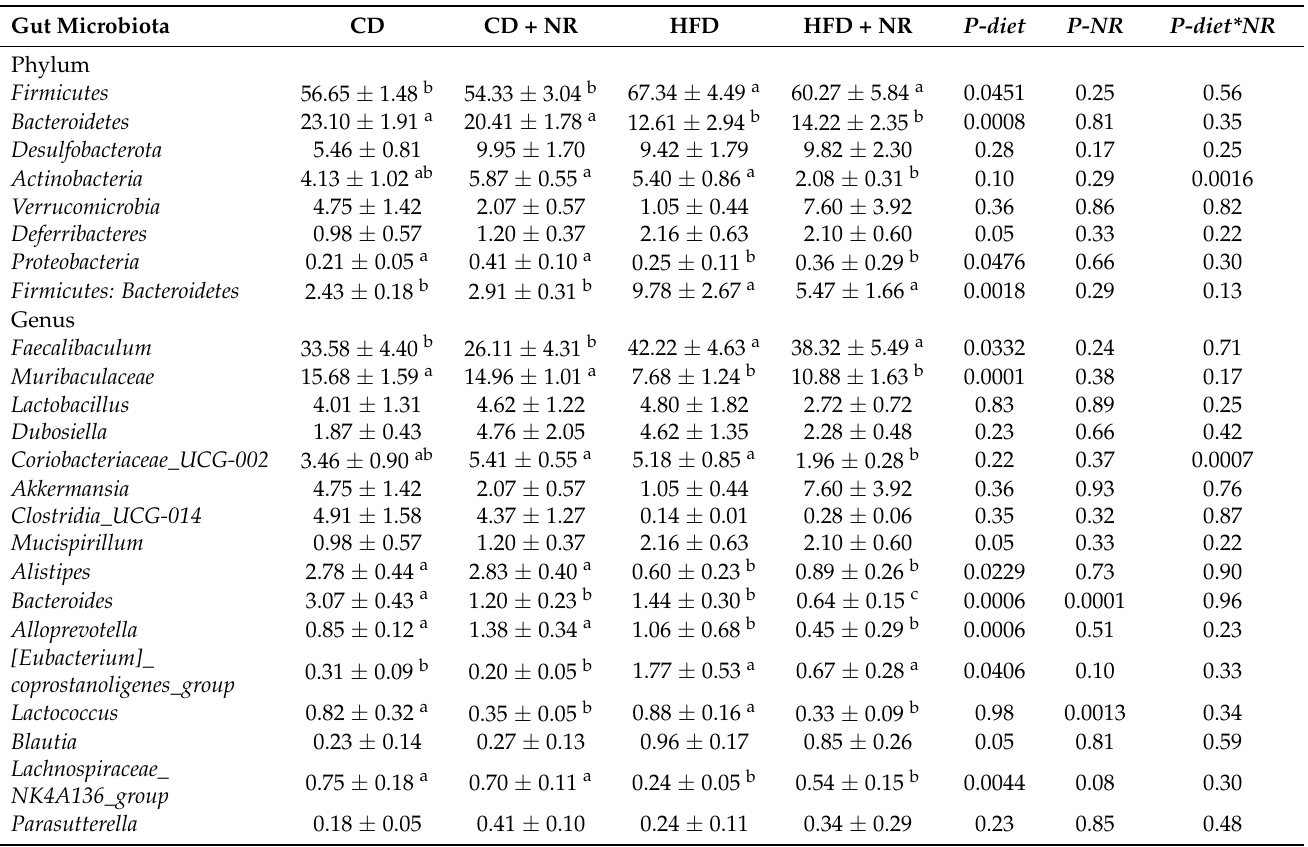
Table 2. Relative abundance of phylum-level and genus-level gut microbiota in ApoE -/- mice fed with a CD or HFD, without or with NR at the end of the study 1